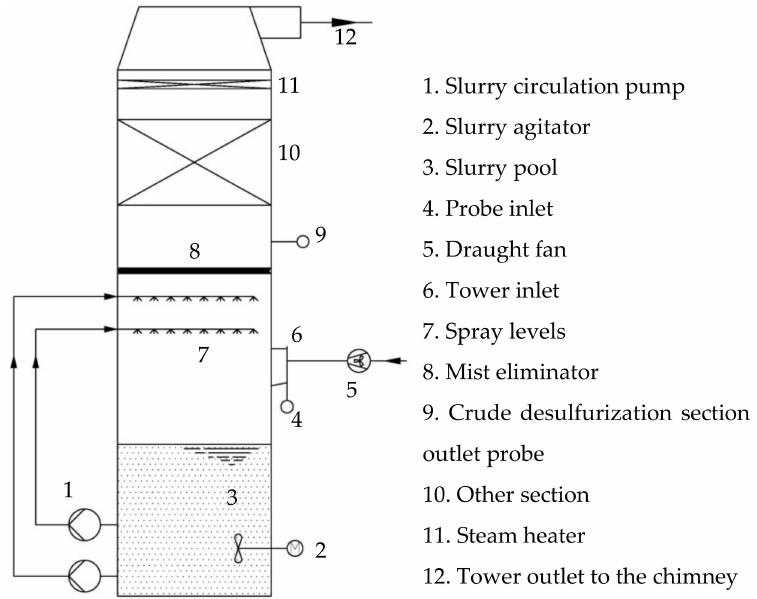
Figure 4. The WFGD process